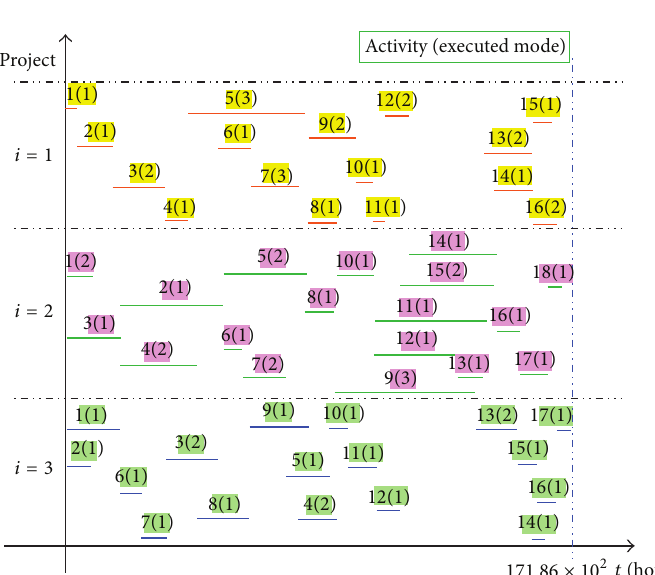
Figure 7: Gantt chart showing the results of the CP-based HPSO algorithm for MRCMPSP in hydropower construction project 𝑋